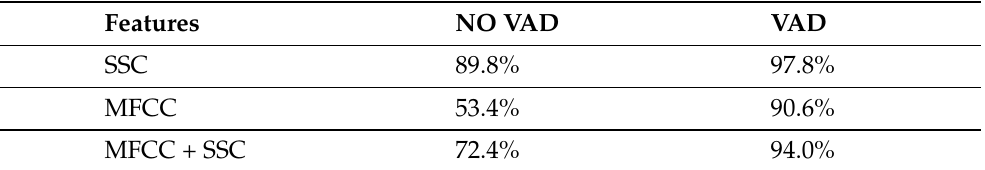
Table 1. Cross-validation accuracy of the Gender Recognition module using SSC, MFCC and their combination on raw/pre-processed audio file.